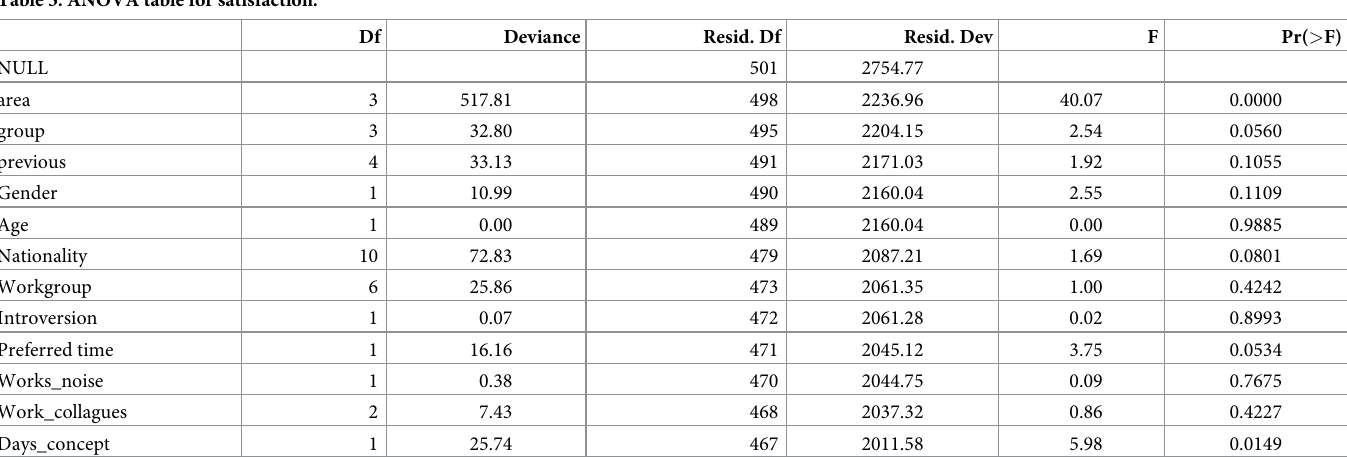
Table 5. ANOVA table for